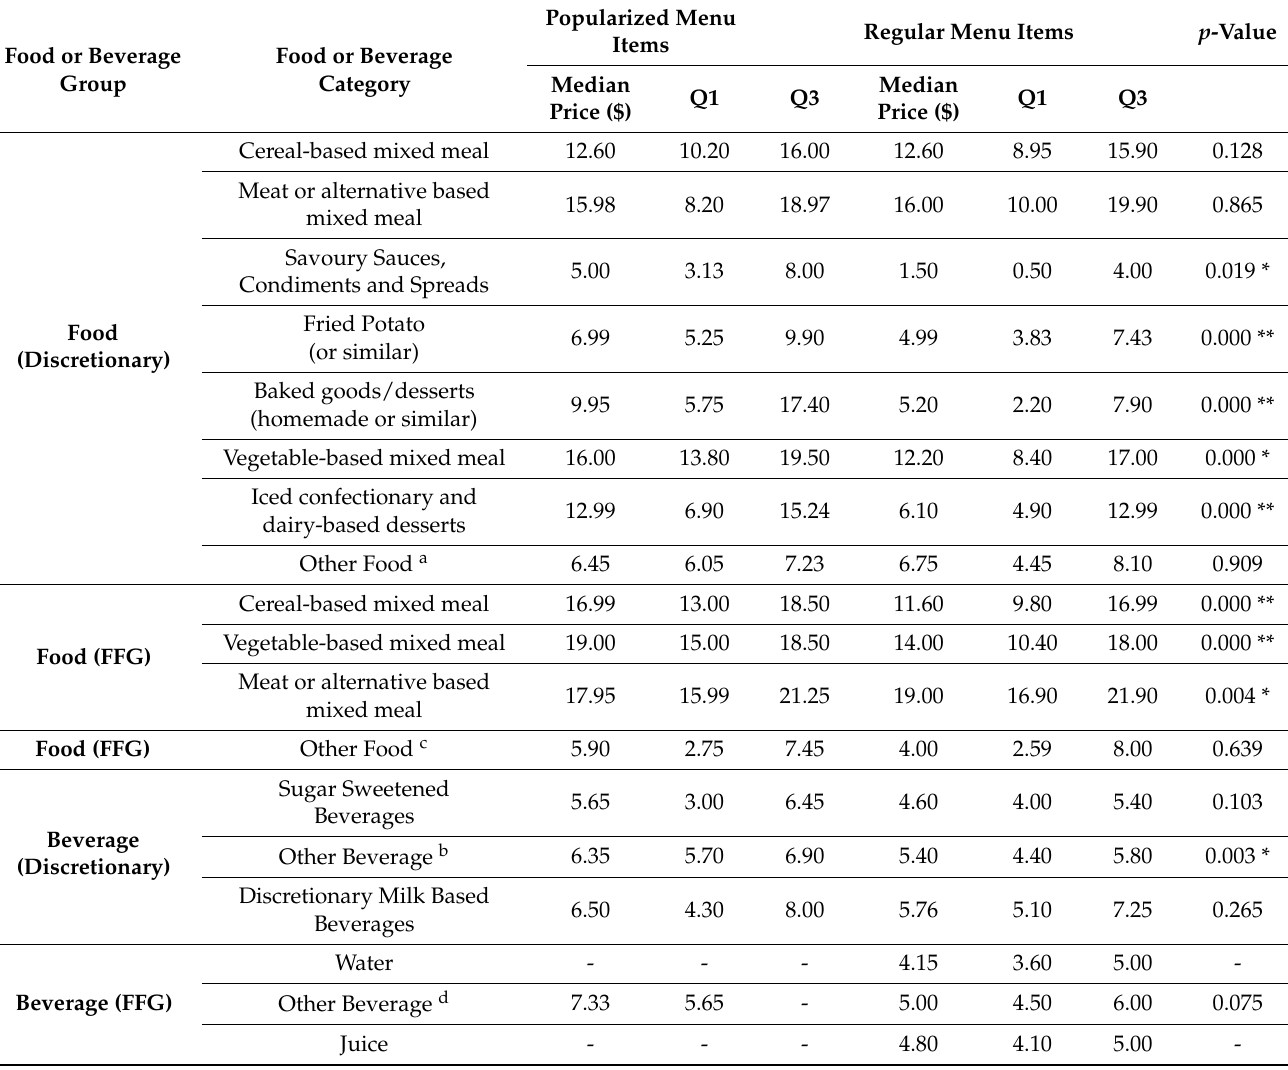
Table 5. Median price (in NZD) of popularized and regular menu items for each food or beverage category. Regular menu items exclude popularized menu items. Catering and party packs,